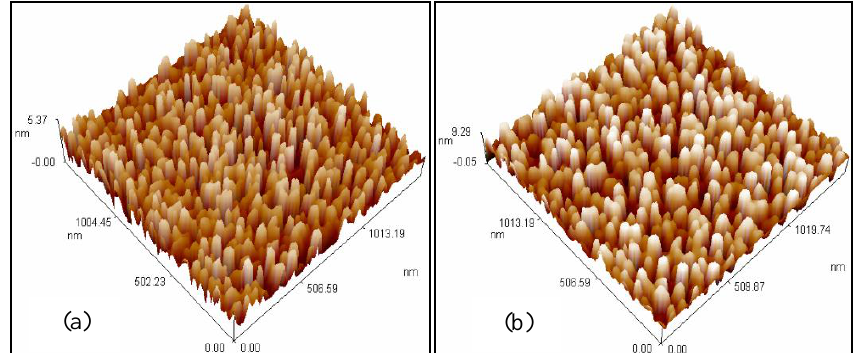
Fig. 9: AFM image of AuNPs /PS/c-Si /Al (a) AuNPs at 160 mJ and (b) AuNPs at 600 mJ.